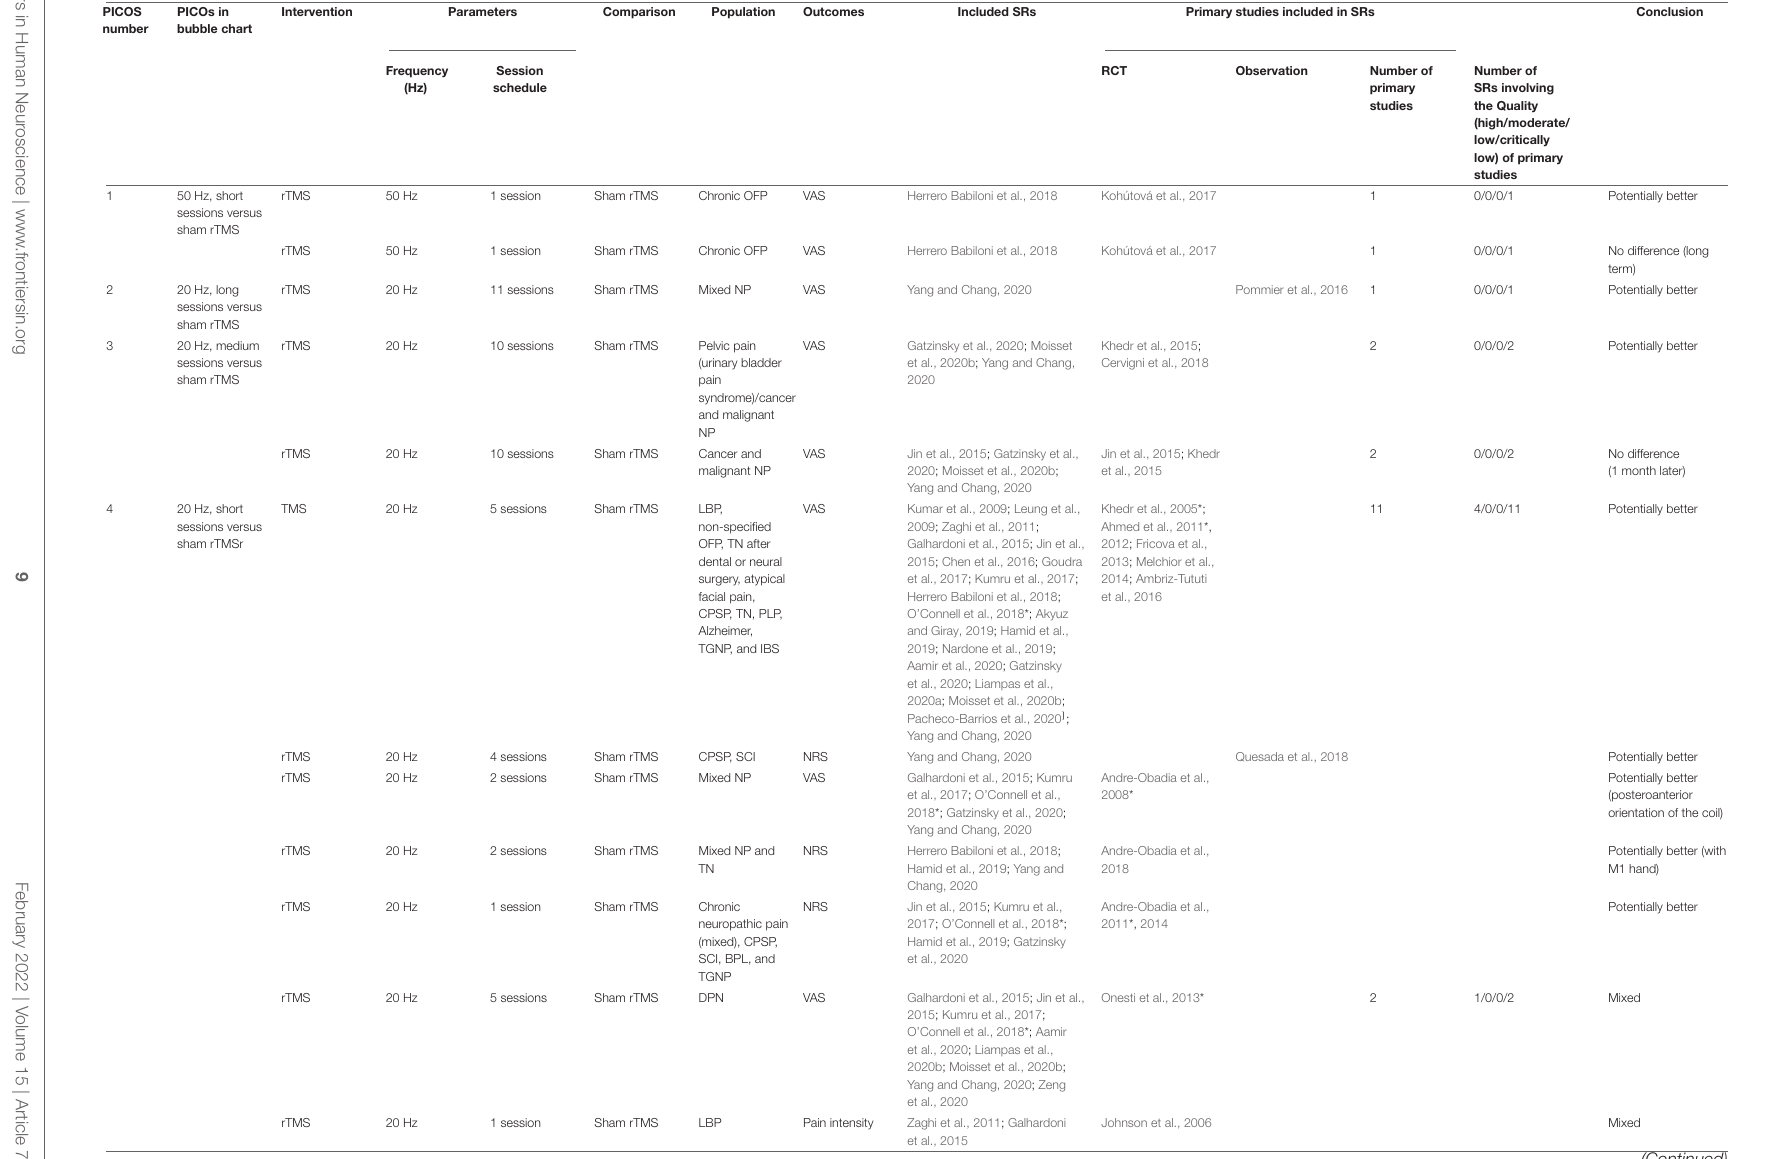
TABLE 2 | PICOs included in systematic